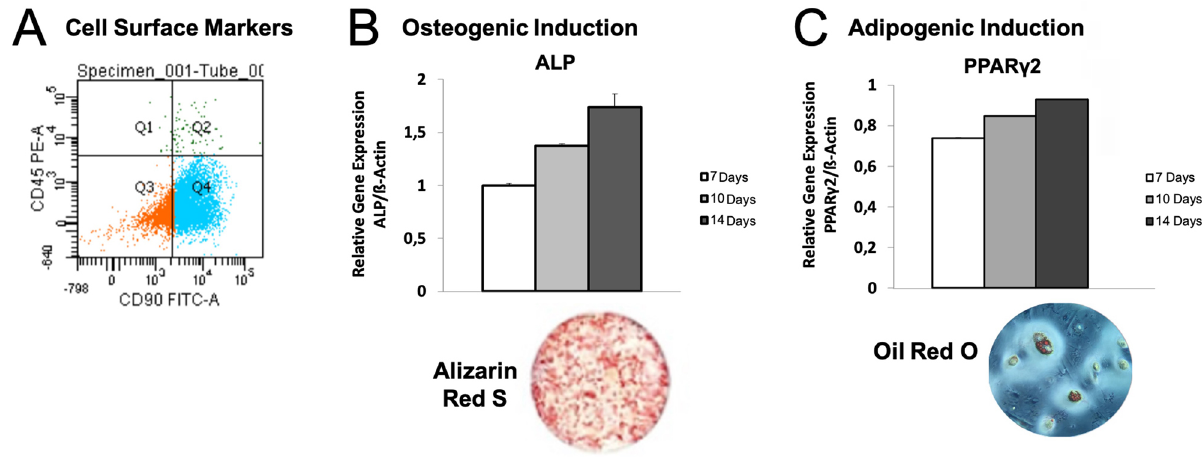
Figure 1- Graphs representing the characterization of bone marrow mesenchymal stem cells (BM-MSCs). (A) Cell surface markers CD45 and CD90 in BM-MSCs. Blue represents the selected BM-MSCs used in the study. (B) Representative wells and relative gene expression of the capacity for osteogenic induction in Alizarin Red S assay and APL gene expression. (C) Representative wells and relative gene expression of the capacity of adipogenic induction in Oil Red O assay and PPARγ2 gene